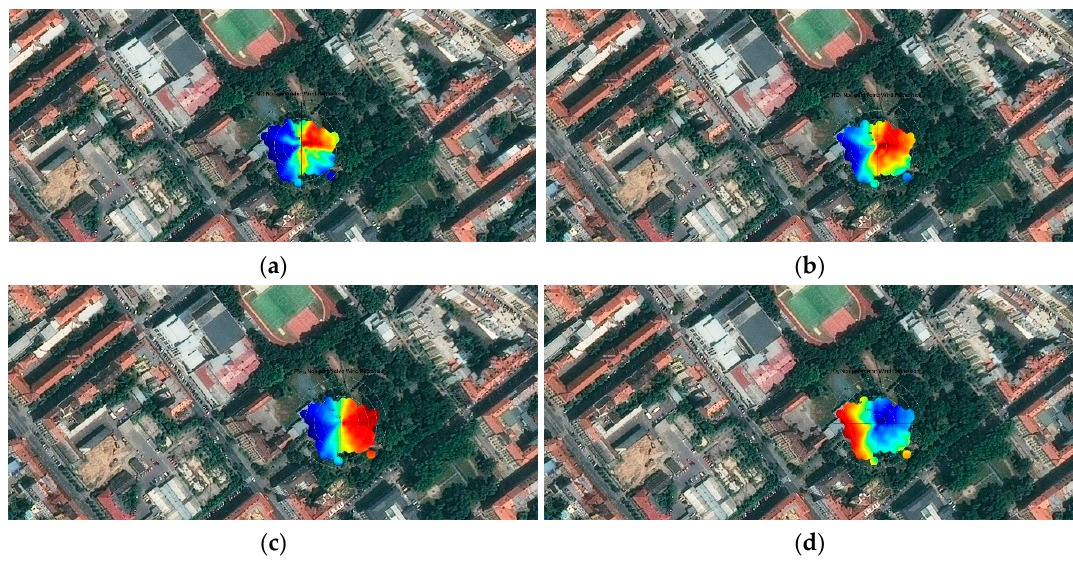
Figure 17. The NO ( a ), NO 2 ( b ), PM 10 ( c ), and O 3 ( d ) concentration relationships to the wind speed and direction at Tyrš ů v sad; sampling started on 8.2.2019 7:00.